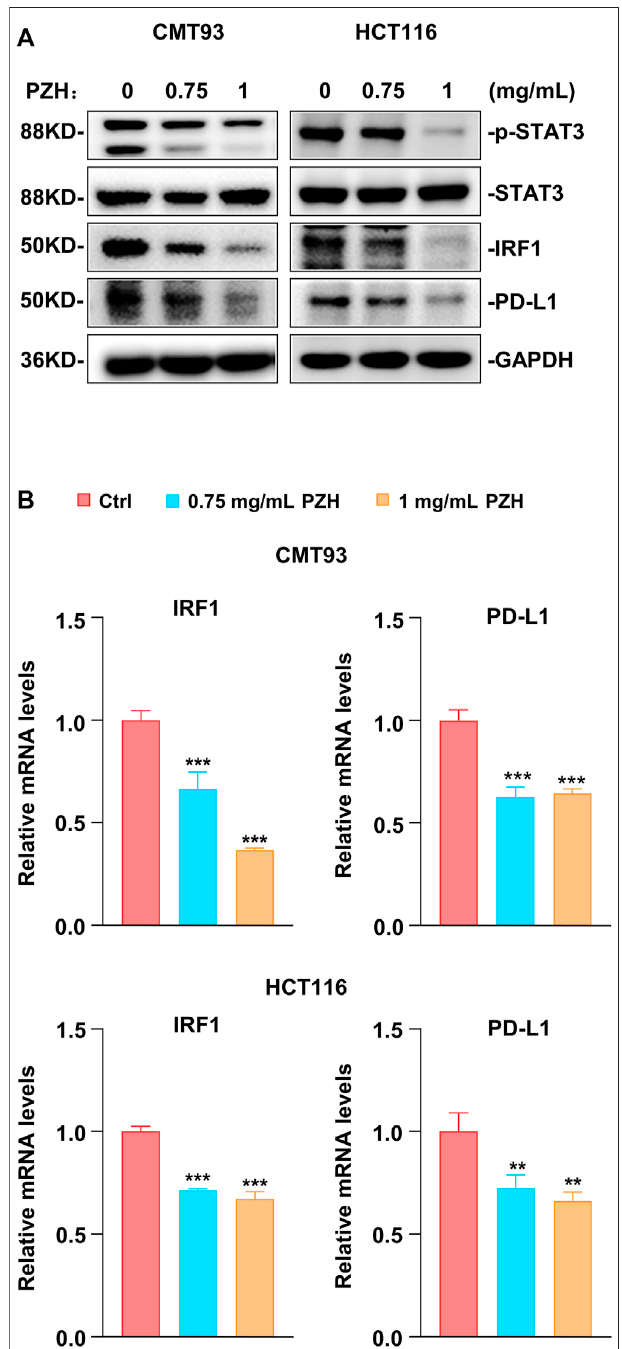
FIGURE 4 | PZH suppressed the basal STAT3-IRF1 signaling to down- regulate PD-L1 expression. (A) The protein levels of p-STAT3, IRF1 and PD- L1weredramaticallyattenuatedinPZHtreatedCMT93andHCT116cells. (B) PZH treatment suppressed the mRNA expression of IRF1 and PD-L1 in CMT93 and HCT116 cells ( n = 3 per group). The results are representative of one of three experiments. Data are presented as means ± SD, ** p < 0.01, *** p < 0.001 based on one-way